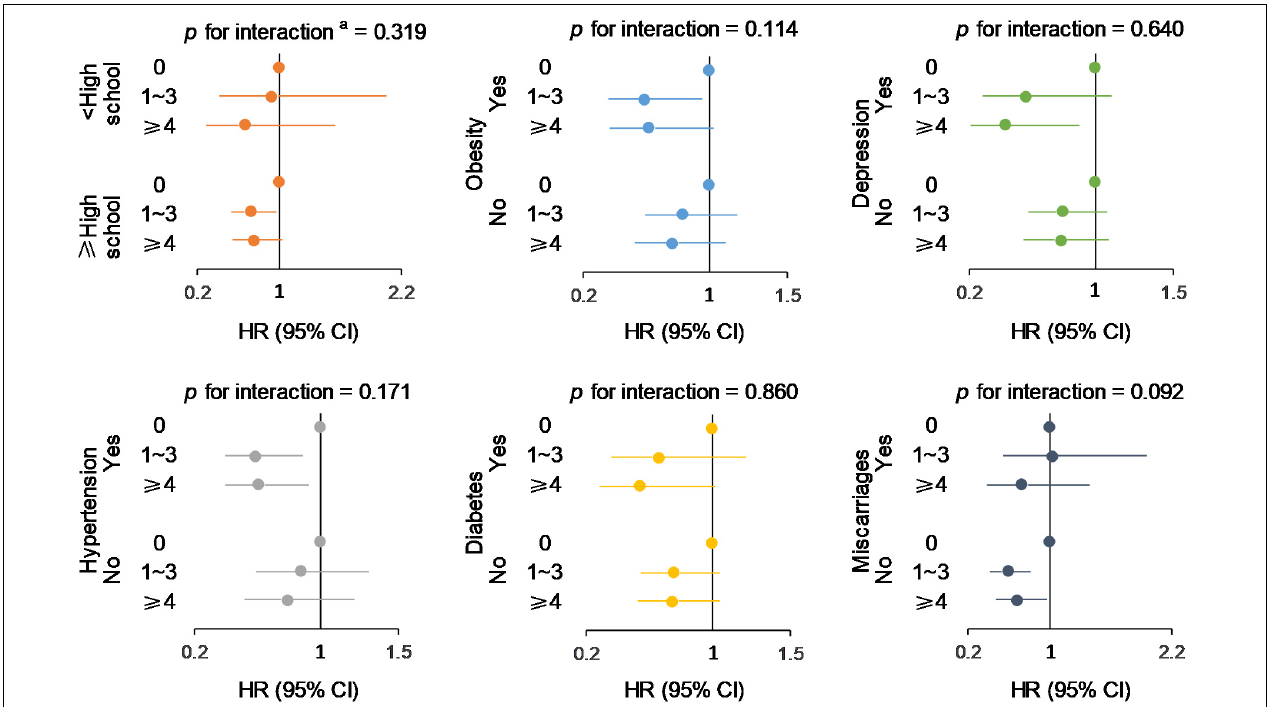
FIGURE 3 | Subgroup analysis of the associations between parity groups and incident MCI/dementia. a Maximum of likelihood ratios test was used to detect the significance of the interaction effect. Models were adjusted for age, race, educational level, employment status, family income, marital status, social support construct scores, age at menopause, BMI, smoking status, alcohol consumption, physical activities, hypertension, DM, CVD, depression, lipid-lowering medication history, and hormone therapy treatment